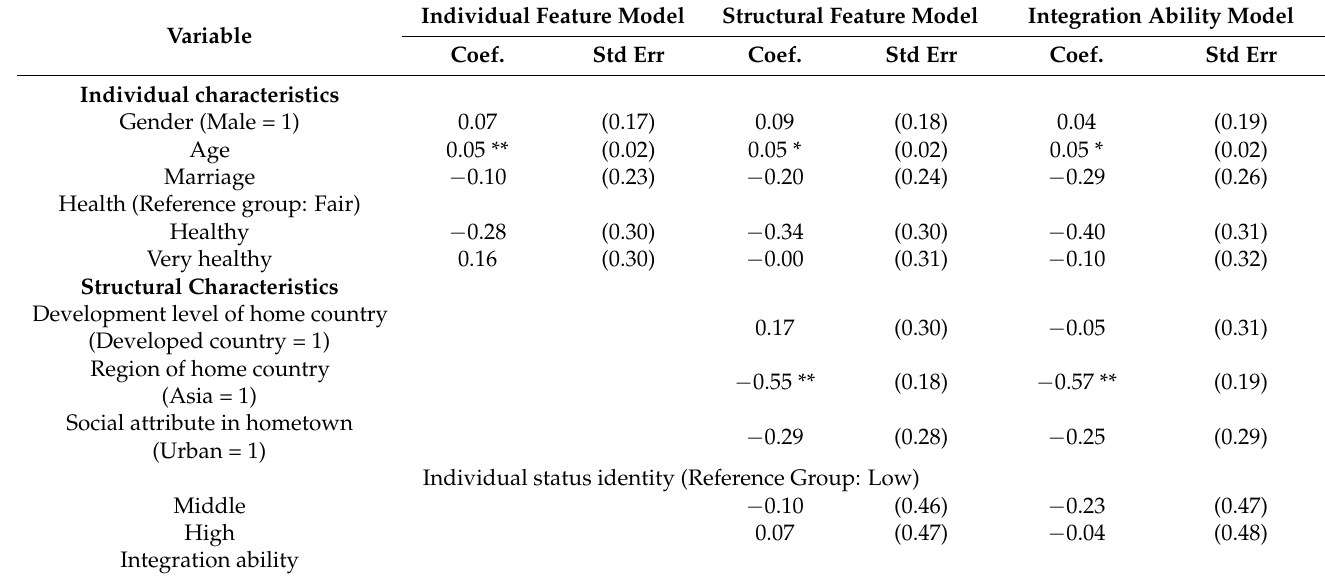
Table 2. Subjective Social Integration Model. (O-Logit Regression